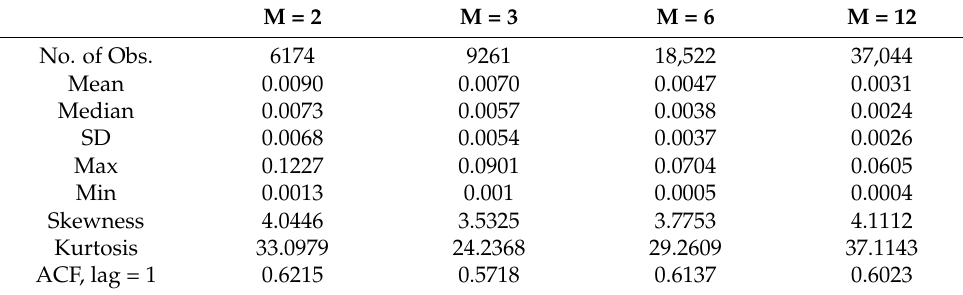
Table 3. Summary statistics of range for log prices from different